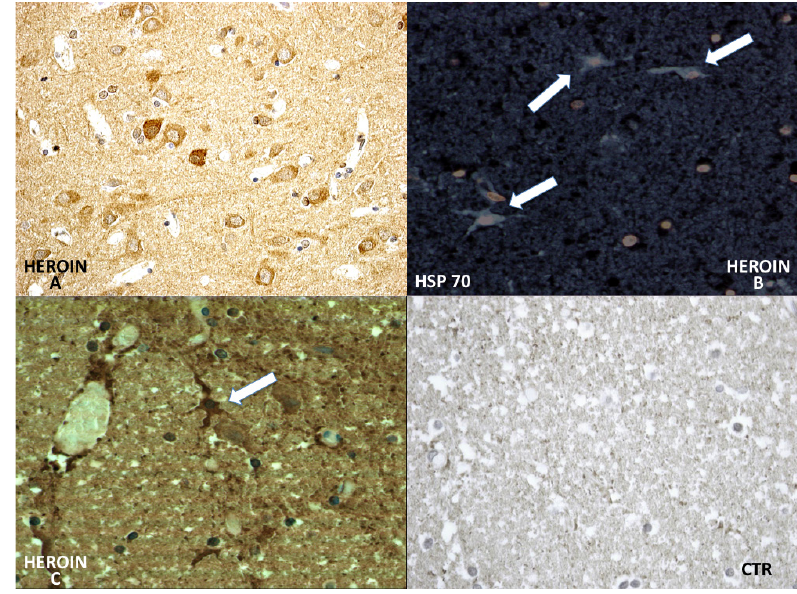
Figure 6. Differential immunohistochemical reaction of HSP-70: a great neuronal ( A ) involvement of HSP-70 expression was observed. The reaction was more intense in the cytoplasm of the neurons and included infrequent HSP-70 protein-positive inclusions in astrocytic fluorescence, well evidenced by use of the confocal microscope ( B ); and ( C ) The positive reaction was well appreciated also by using the bright field. Negative control case